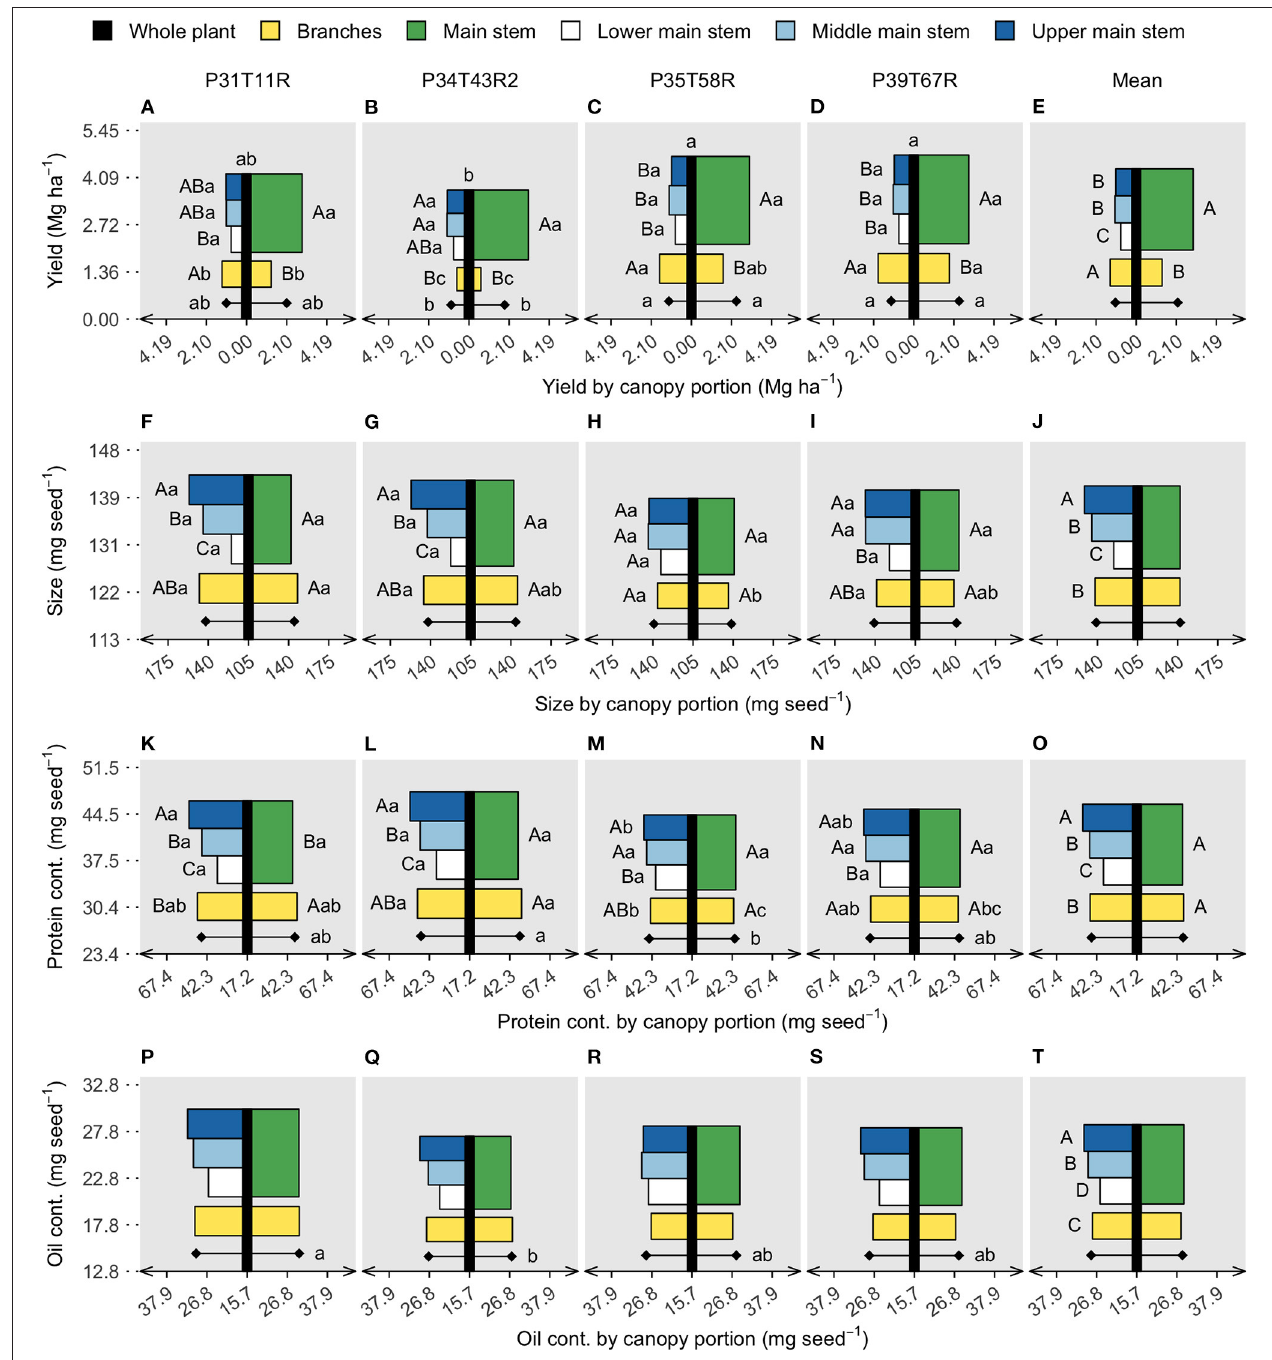
FIGURE 2 | Soybean seed protein (A–E) and oil concentration (F–J) , limiting amino acids (LAAs) abundance (K–O) , and oleic/(linoleic + linolenic) ratio (P–T) . Vertical black bars refer to the whole plant data in the y axis, with lowercase letters on top comparing genotypes (model 1). Horizontal bars are centered on the black bar (x axis), referring to two canopy portions on the right side (main stem and branches) (model 2) and four canopy portions on the left side (lower, middle, and upper main stem segments and branches) (model 3). Diamonds represent the genotype mean of all canopy portions for models 2 and 3. Uppercase letters compare stem segments within genotype (interaction) or on the overall mean (portion effect). Lowercase letters compare genotypes within canopy portions (interaction) or on the genotype mean, diamonds (genotype effect). Each panel row portraits three linear models of a response variable, for the whole plant, two and four canopy portions. Absence of letters represents no significant difference ( p <